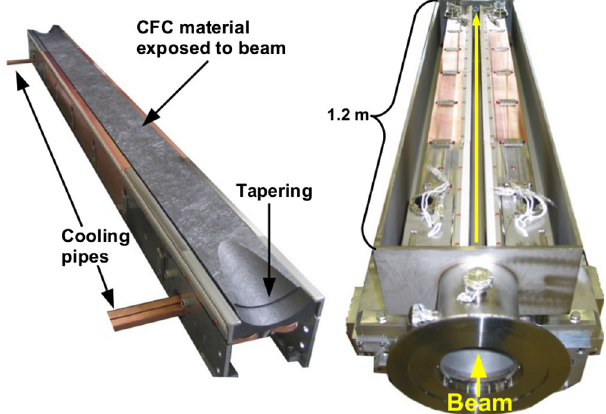
FIG. 3. A secondary collimator jaw made of CFC (left) and two parallel jaws installed in a collimator tank seen from the top (right), where the beam should pass in the center between the jaws. The primary collimators are similar but with an effective length of only 60 cm.